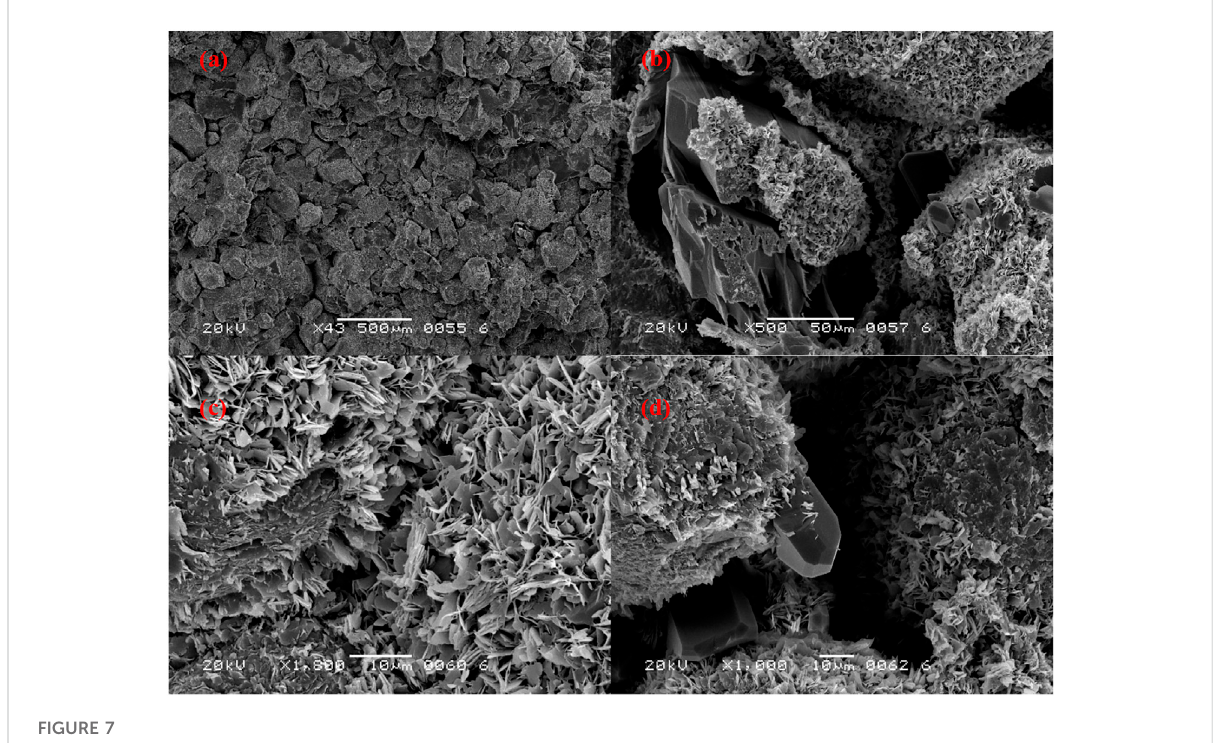
FIGURE 7 SEM image of No. 9 core of Zhoufu 59 – 51